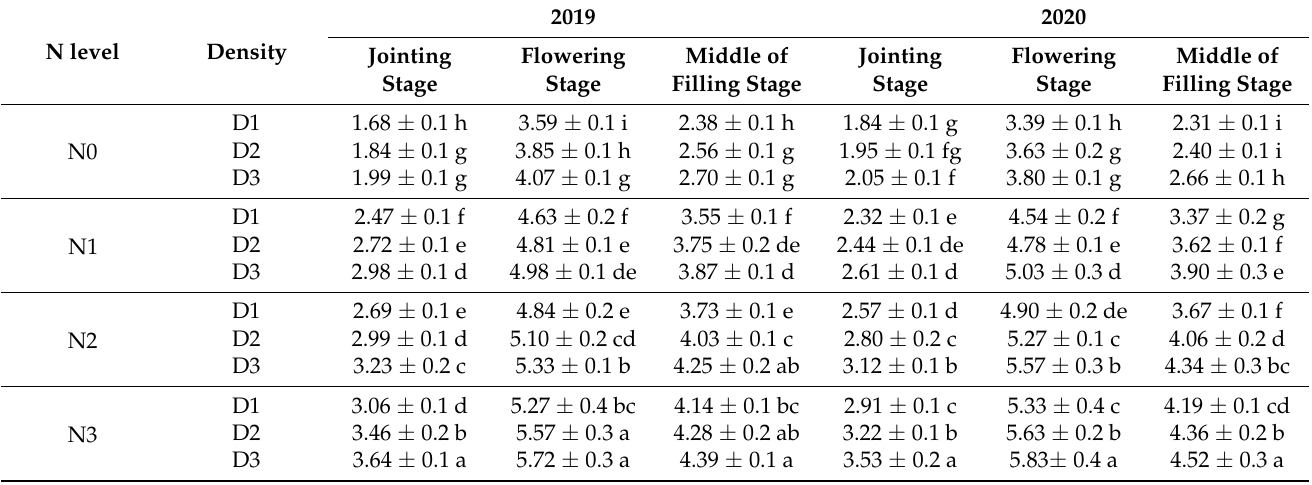
Table 4. The interaction of increasing density and decreasing N on leaf area index ( LAI ) at different growth stages.